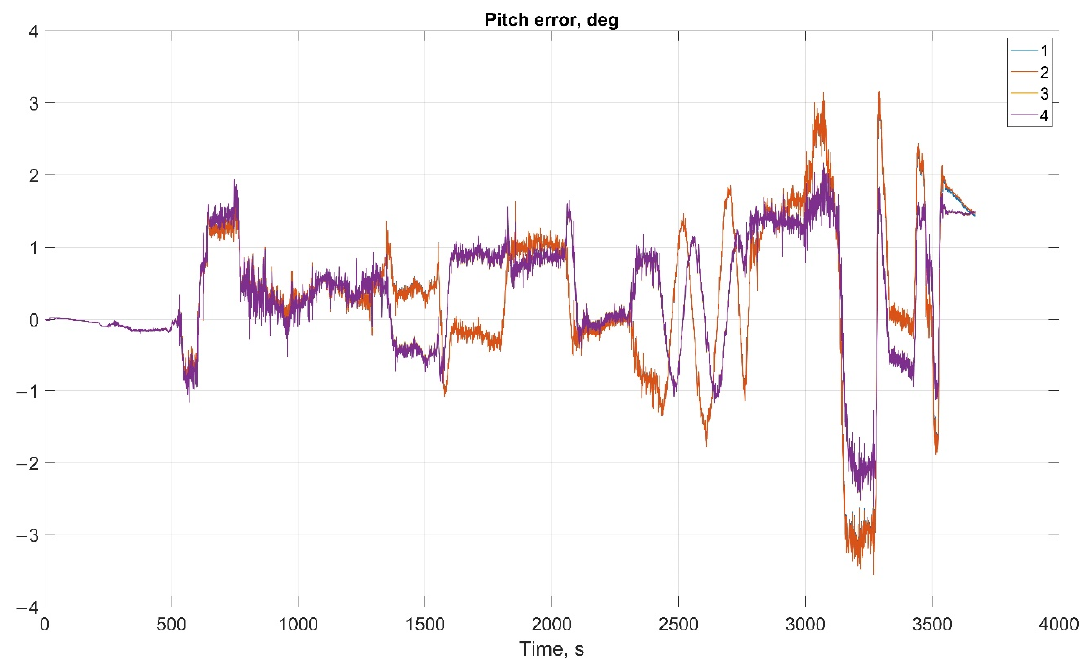
Figure 20. Pitch error in helicopter test (1, Transformation matrix approach; 2, Direct angles calculation approach; 3, Transformation matrix approach using GNSS data; 4, Direct angles calculation approach using GNSS data).